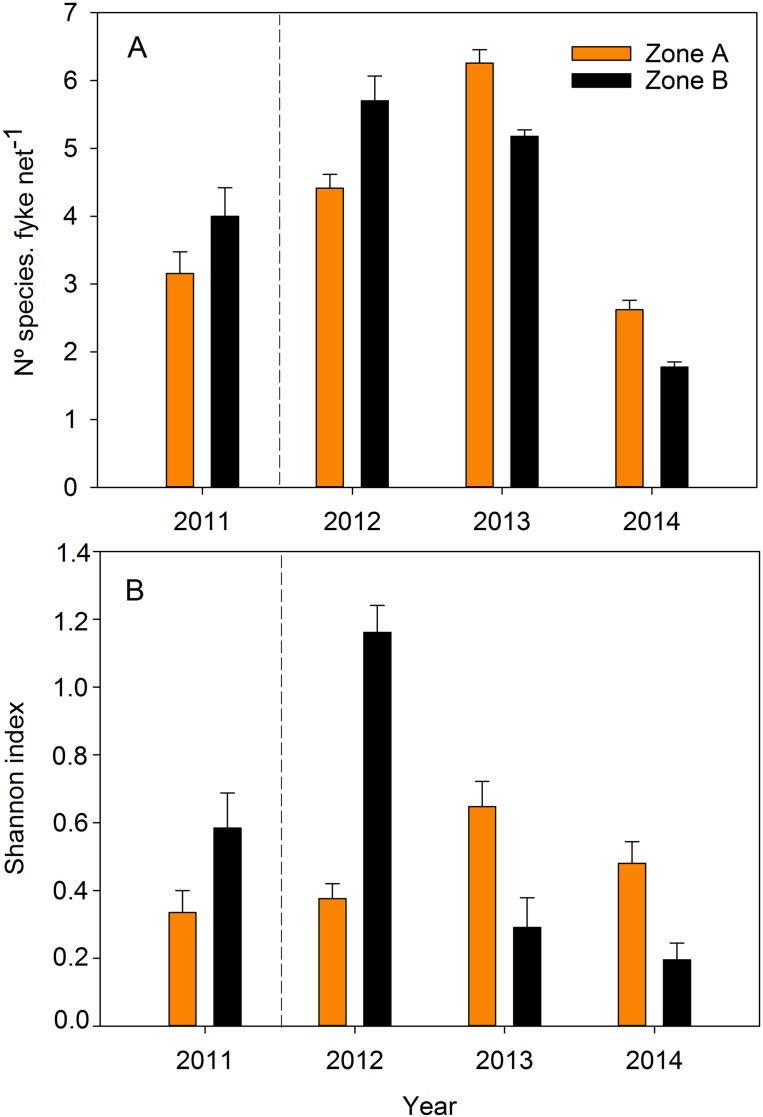
(A) Species richness, and (B) Shannon diversity index for fishes and crustaceans collected with fyke nets in the two zones of the study area during the four study years.The dotted line indicates the moment at which restoration took place between 2011 and 2012. Error bars are the standard error.